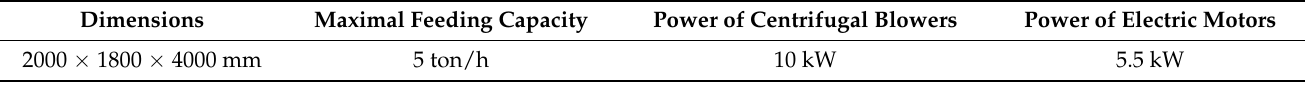
Figure 5. Three-dimensional model of LFM cleaning machine. Table 1. Main parameters of LFM cleaning